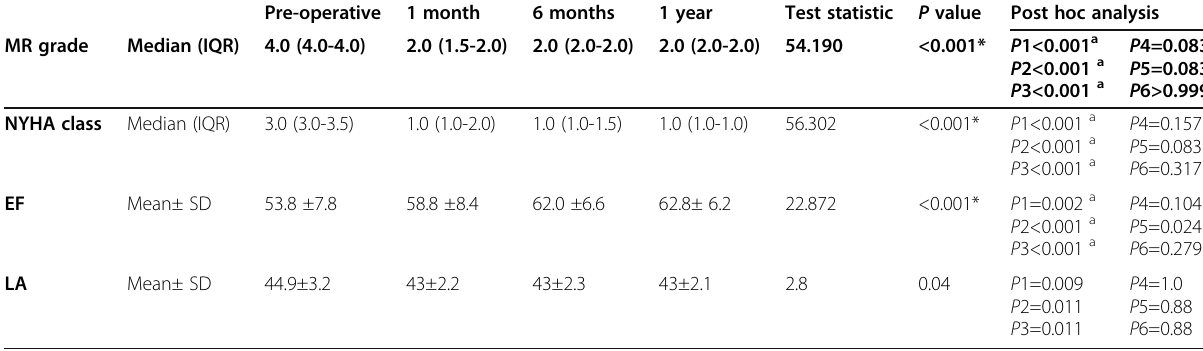
Table 6 Follow up of the mitral regurgitation grade, NYHA class, ejection fraction, and the left atrium